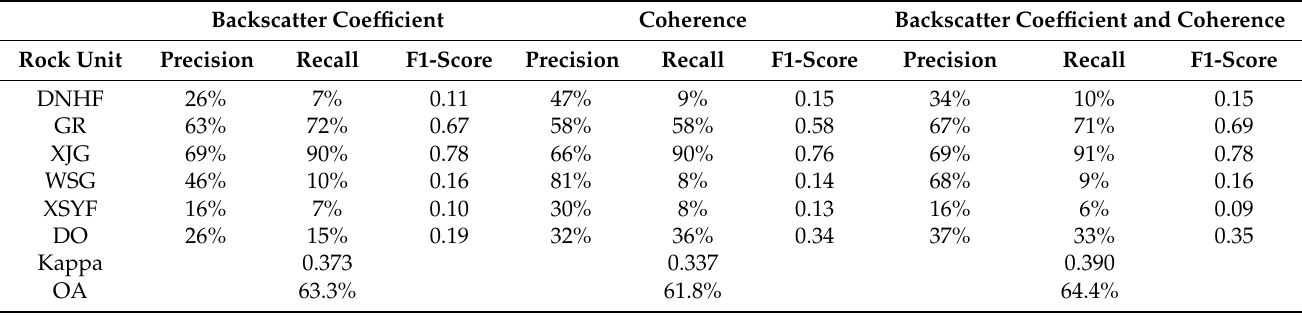
Table 4. Accuracy assessment of the result using time-series backscatter coefficient, coherence, and both backscatter coefficient and coherence. Coherence Backscatter Coefficient and